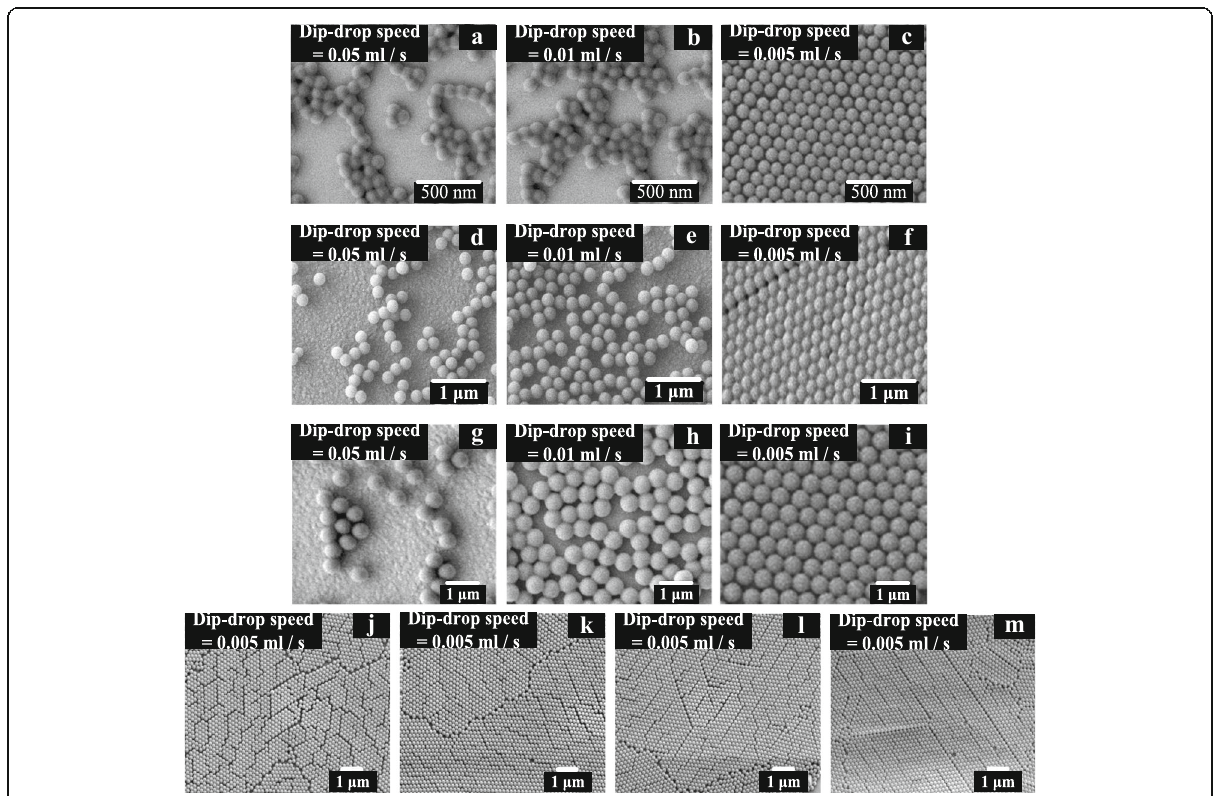
Fig. 2 SEM images of PS NSs with diameter of 100, 200, and 500 nm at the average dip-drop speed of a , d , g 0.05 mL/s; b , e , h 0.01 mL/s; and c , f , i 0.005 mL/s, and the SEM images of PS NSs with 200 nm and average dip-drop speeds of 0.005 mL/s at the regions of j upper-right, k upper- left, l lower-right, and m lower-left of 0.5 × 0.5 mm 2 ITO-coated glass substrate . The concentrations of DI water-diluted PS NS suspension were 4.1 × 10 11 spheres/cm − 3 for the 100-nm PS NSs, 5.1 × 10 10 spheres/cm − 3 for the 200-nm PS NSs, and 3.2 × 10 9 spheres/cm − 3 for the 500-nm PS